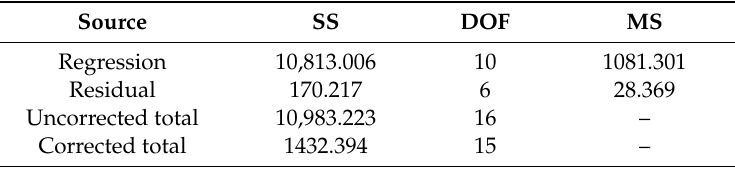
Table 7. ANOVA for the response surface model of α Y .